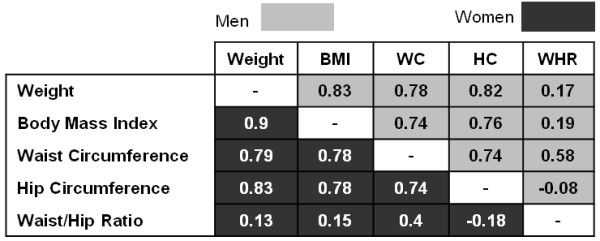
Age-adjusted partial correlation coefficient among anthropometric measures in urban adults of Cameroon. Findings of the 2003 Cameroon Burden of Diabetes Baseline Survey. All coefficients significantly different to zero (P < 0.05). WC (Waist Circumference in cm), HC (Hip Circumference in cm), BMI (Body Mass Index in kg/m2), WHR (Waist-to-Hip Ratio).